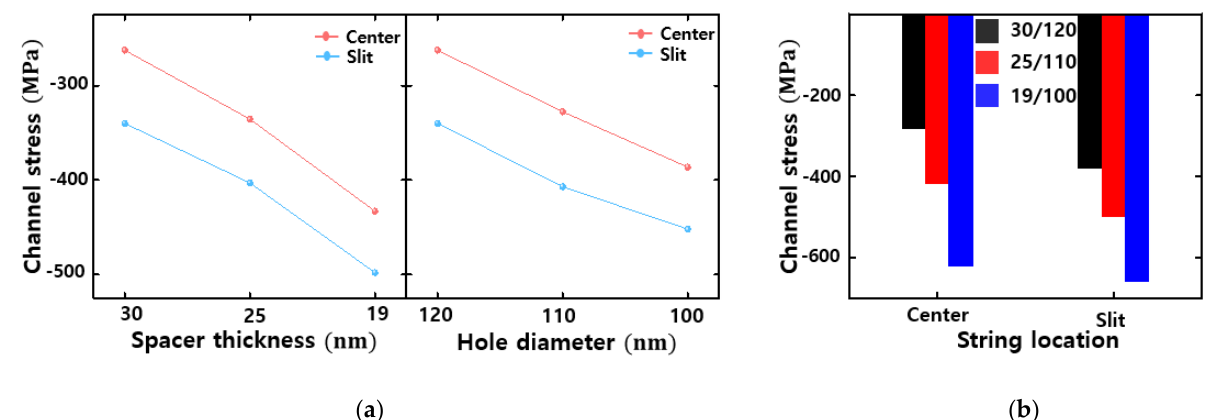
Figure 4. The channel stress of the two strings with respect to the distance from the common source line. The channel stress of two strings when the spacer thickness and hole diameter were ( a ) individually scaled and ( b ) both scaled.